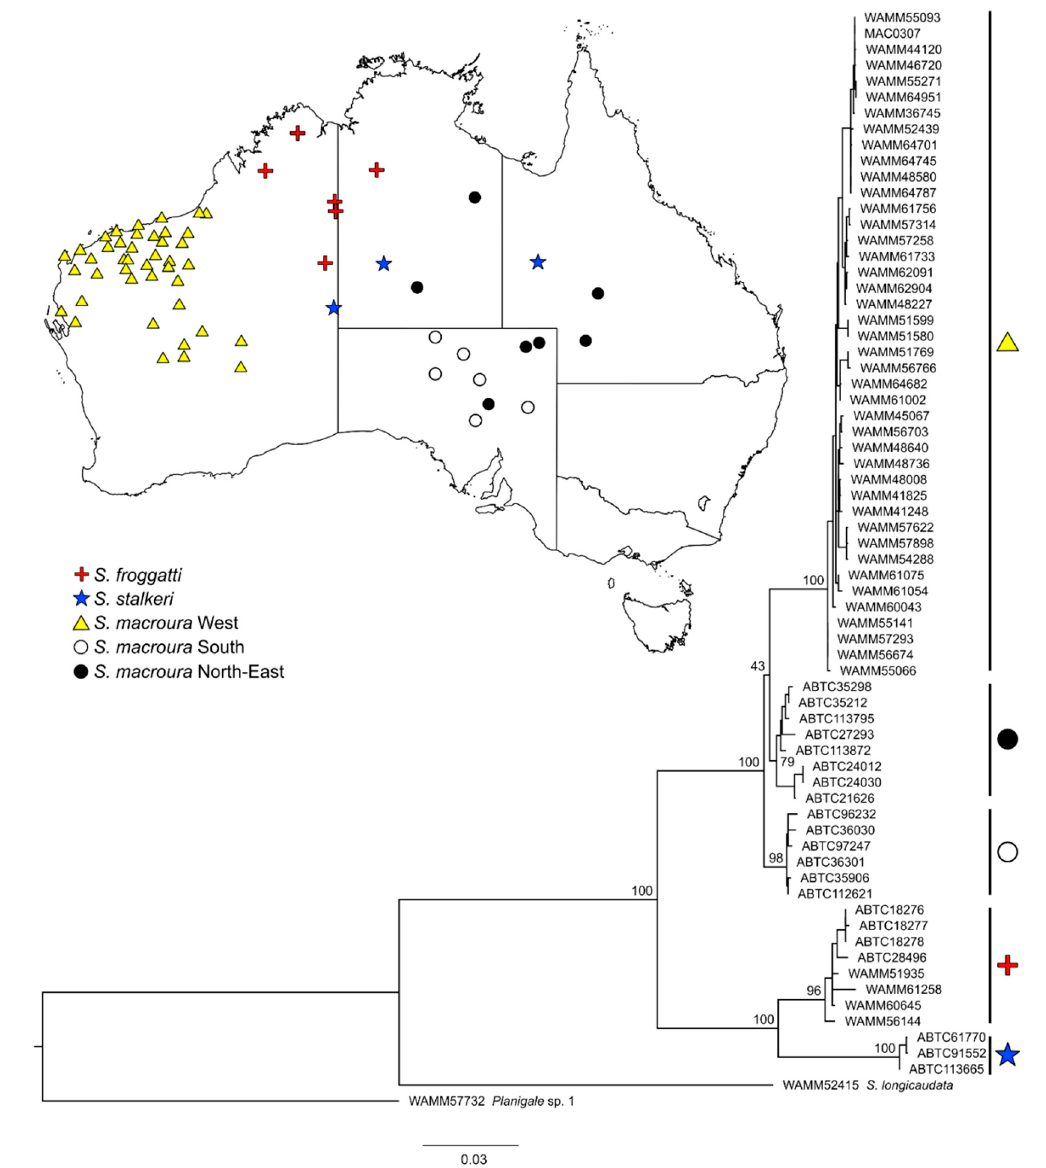
Figure 2. Maximum likelihood tree of Sminthopsis macroura complex using concatenated (control region, cytochrome b, and omega globin) sequence data. Bootstrap support for major nodes is shown. Names of S. macroura populations follow Blacket et al. [39].